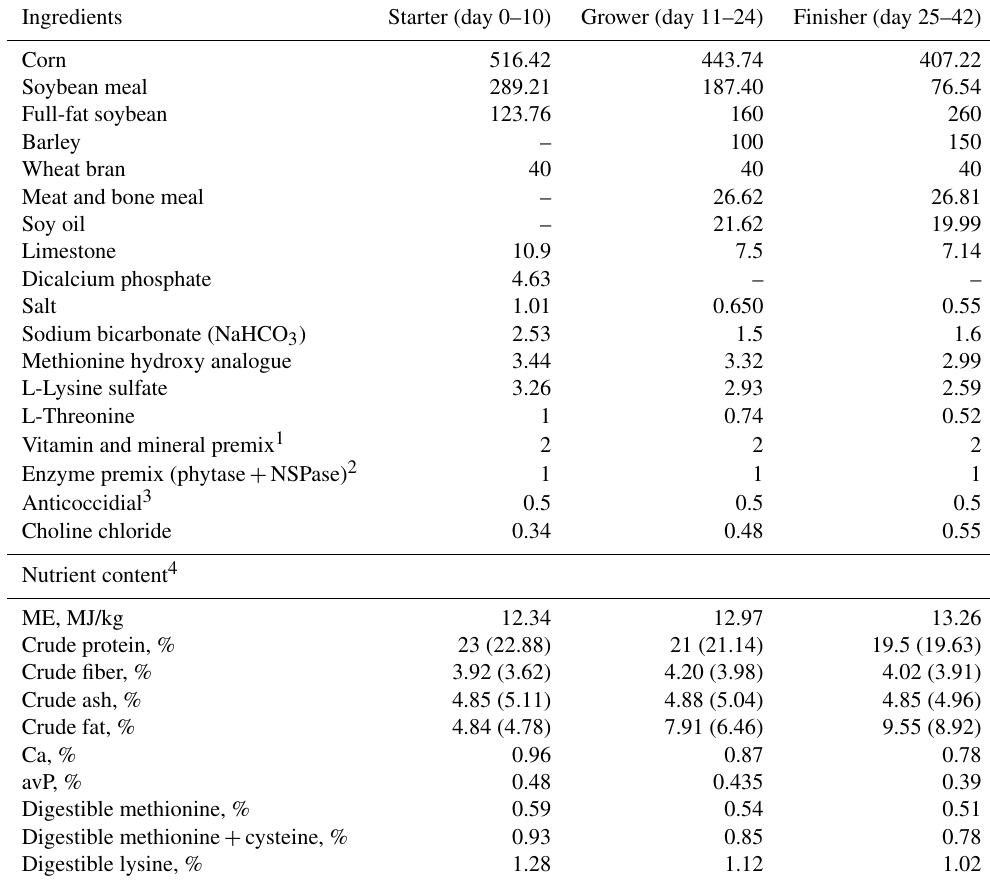
Table 1. Composition of basal diets for different growth phases (gkg − 1 , as feed basis).